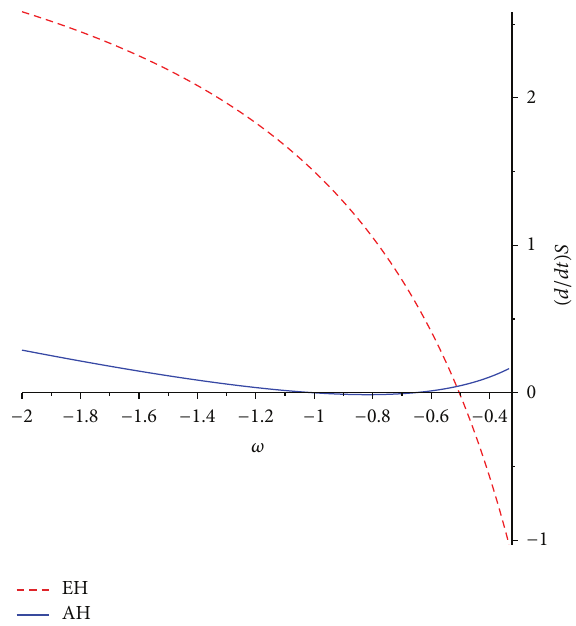
Figure 1: GSLT for RSII brane for perfect fluid with constant equa- tion of state.